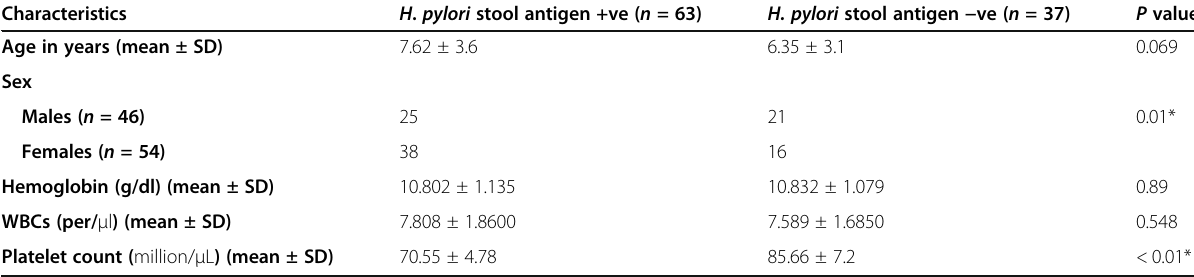
Table 1 Baseline demographic and clinical characteristics of study patients Characteristics